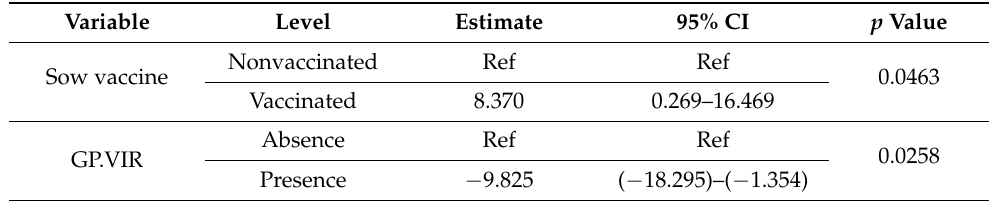
Figure 4. Levels of IL-8 ( A ) and Il-10 ( B ) in sera from piglets born to vaccinated and nonvaccinated sows. Serum samples were taken at 7, 15 and 21 days of life. Empty dots represent the piglets from nonvaccinated sows, whereas black dots represent piglets nursed by vaccinated ones. Individual piglet results can be found in Figure S3A,B. Table 2. Final model with the association of log10 IL-8 and predictor variables using multivariable mixed linear regression with time as a random effect. GP.VIR: colonization of the nasal cavity of the piglets with virulent G. parasuis strains at the end of the